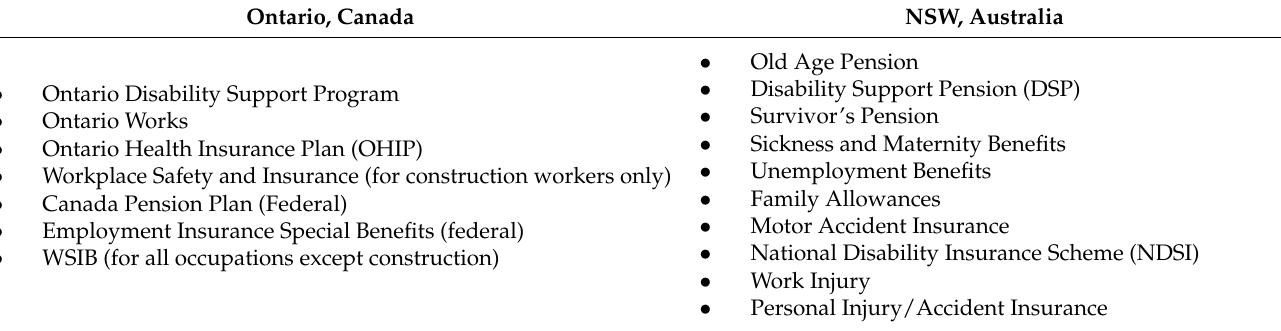
Table 6. Key Supportive